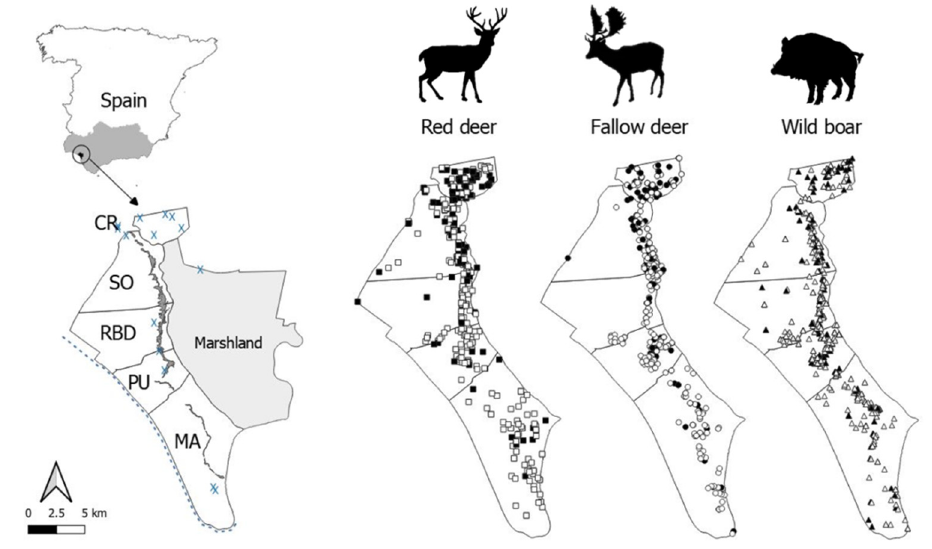
Figure 1. Map of the study area, Doñana National Park. The sampling areas (cattle management units: Coto del Rey (CR), Sotos (SO), Doñana Biological Reserve (RBD), Puntal (PU) and Marismillas (MA)) are delimited and the ecotone and small human settlements are displayed by a dark band and blue “X”, respectively. Red deer (squares), fallow deer (circles), and wild boar (triangles) sampled are shown. Black and white symbols mean animals positive and negative for antibodies against Toxoplasma gondii , respectively.